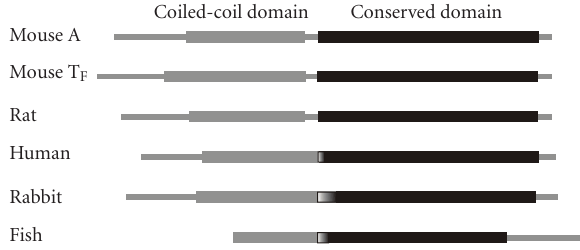
Figure 1: Schematic representation of the ORF1 protein. The thin bar for each species represents the entire length of the protein. Thicker bars represent the coiled-coil (gray, based upon coils anal- ysis [10]) and conserved domains (black, based upon multiple- sequence alignments using T-Co ff ee [11]). These two domains over- lap in the human, rabbit, and fish, but not the two mouse or rat ORF1 protein sequences, as indicated. Sequences used were mouse A101 (Q91V68l, [12]), mouse L1spa (O54849, [13]), rat (Q63303), human L1rp (AAD39214, [14]), rabbit ([15], not in GenBank), and fish swimmer (AAD02927, [16]). The two mouse and the human ORF1 protein sequences are from retrotransposition-competent el- ements; the other sequences are from untested elements. A model for the trimeric structure of mouse L1 and its role in TPRT appeared in [17] by Martin et